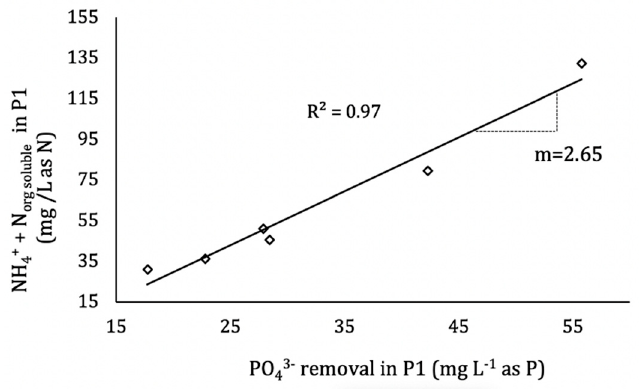
Figure 4. Correlation between concentration removal of PO 43 − and NH 4 + + N org soluble in P1 for the six study periods during the 2017 operating season.